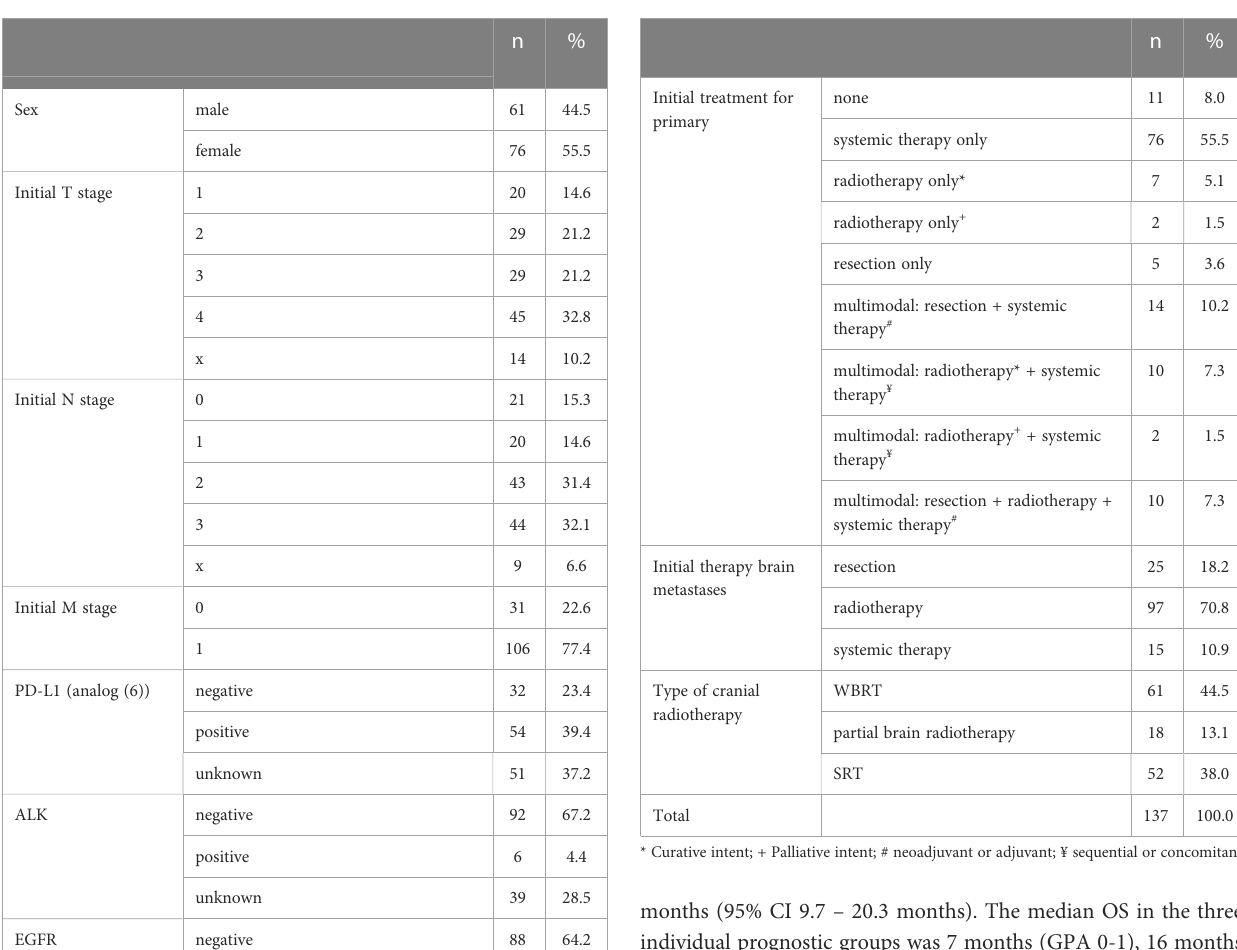
TABLE 1 Patient